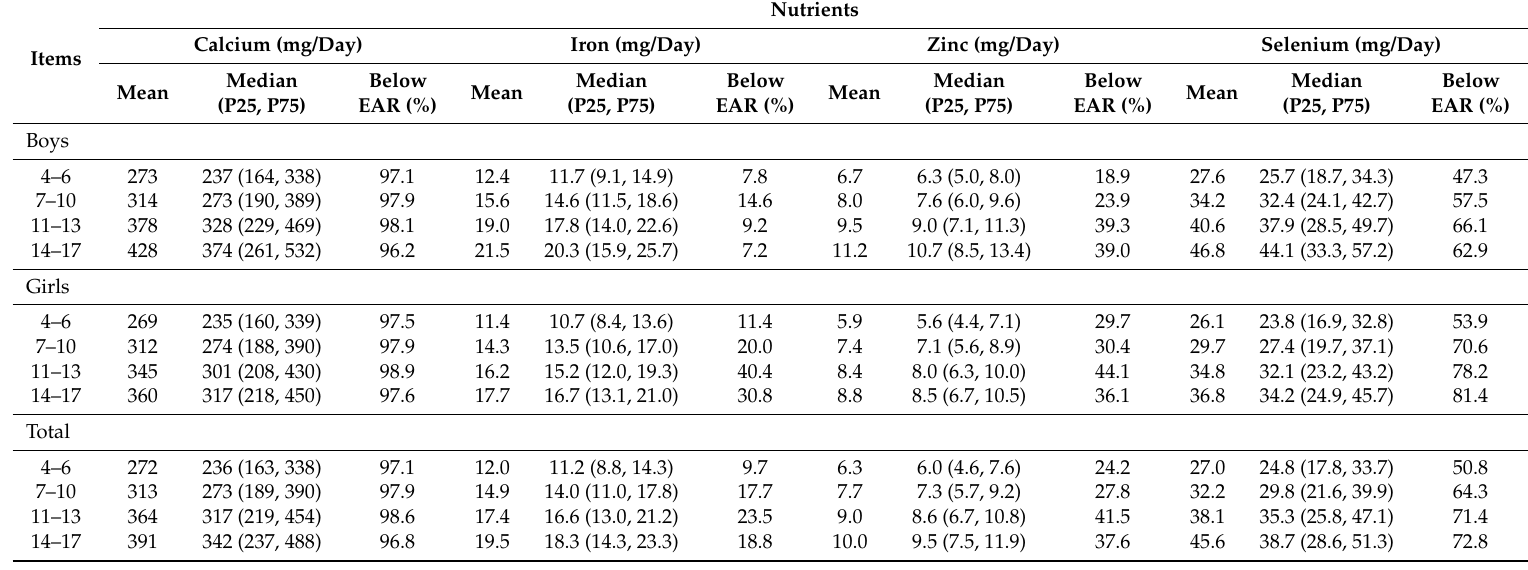
Table 2. Usual daily intake and proportion below the estimated average requirements (EAR) for calcium, iron, zinc and selenium among Chinese